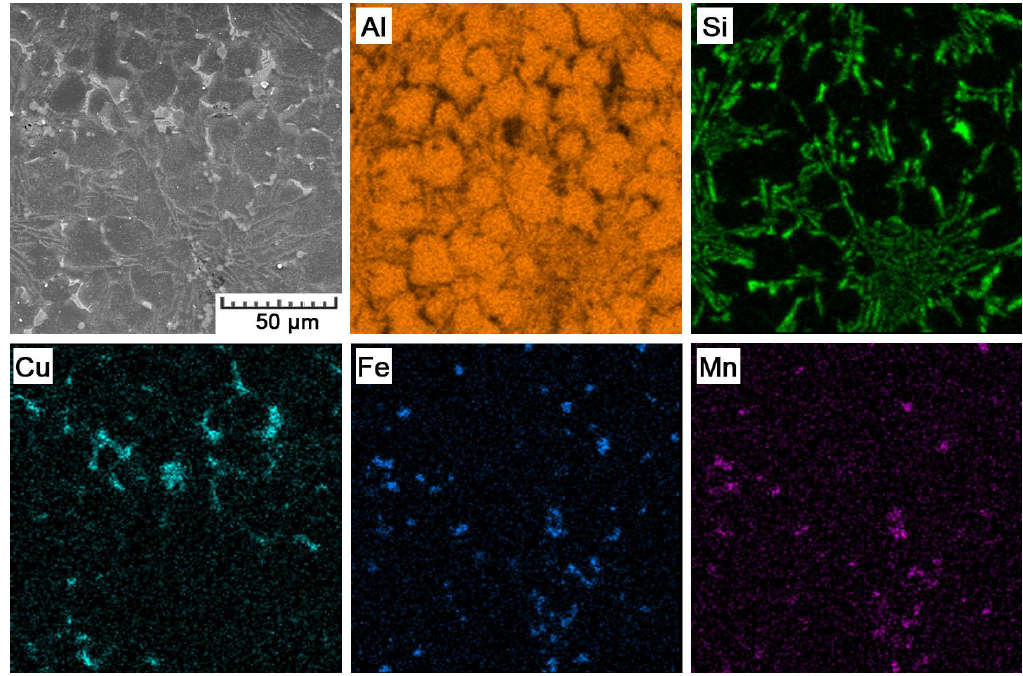
Figure 11. EDS maps showing the distribution of alloying elements in the HPDC AlSi 9 Cu 3 Fe alloy.